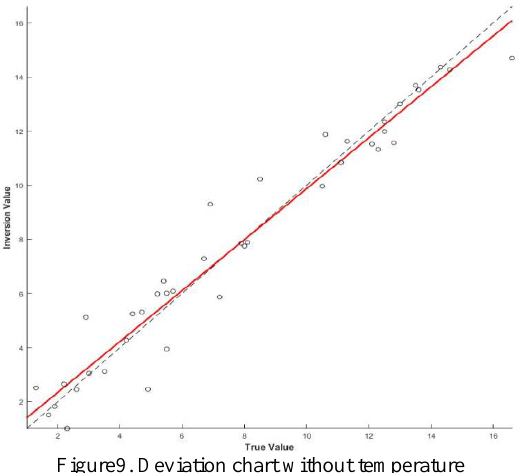
Figure9. Deviation chart without temperature Water depth information reflects the topography of shallow seas. underwater topography in coastal area. Based on the water depth information, the visualization display of underwater topography can be realized as shown in Figure10.